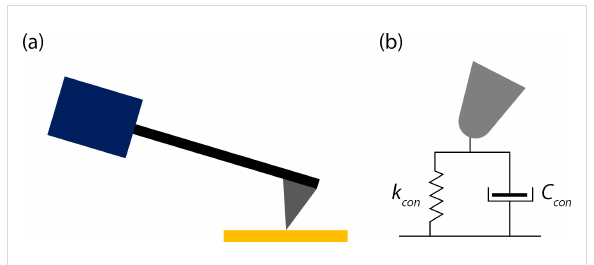
Figure 9: (a) Schematic of the physical construction of the cantilever. A piezo actuator (blue rectangle) excites the cantilever/tip assembly that is in contact with a sample (yellow rectangle). (b) A Kelvin–Voigt model representing the tip–sample contact in dynamic AFM